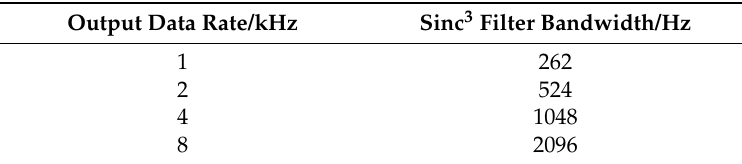
Table 1. The sinc 3 filter bandwidth for set values of the output data rate.